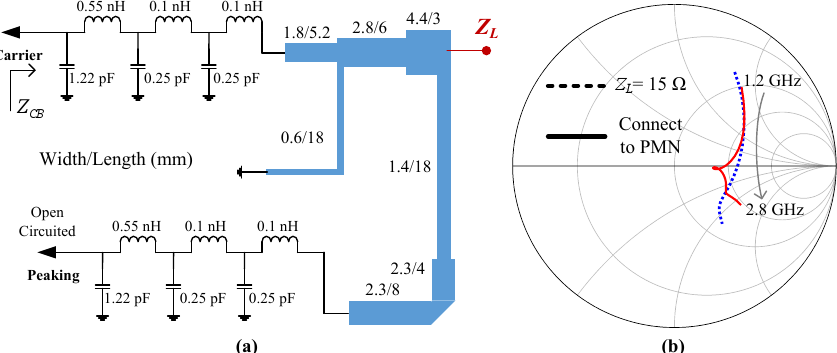
Figure 6. ( a ) Simulation schematic and ( b ) results of the proposed combiner using complex combining impedance.